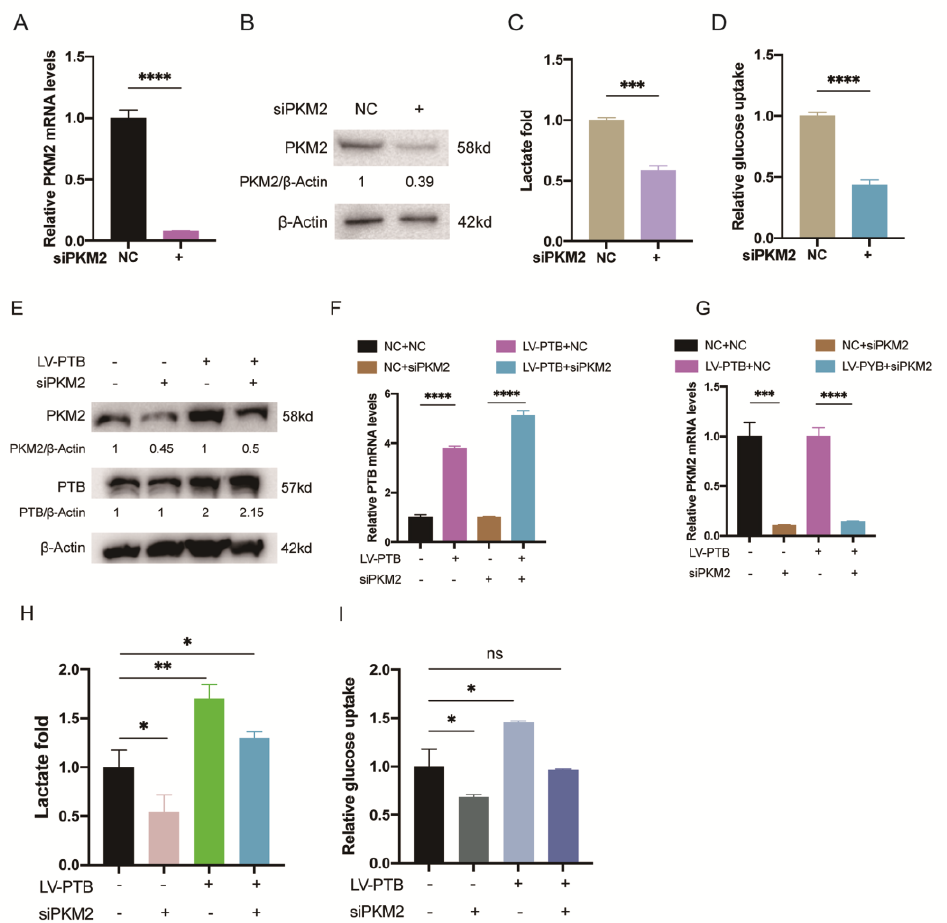
Figure 5. PTB regulates aerobic glycolysis through alternative splicing of PKM. ( A , B ) The efficiency of PKM2 silencing. Lactate production ( C ) and glucose uptake ( D ) were measured in the KFb transfected with siKM2. The overexpression efficiency of PTB and the silencing efficiency of PKM2 were confirmed by Western blotting ( E ) and qRT-PCR ( F , G ). Lactate production ( H ) and glucose uptake ( I ) were detected to measure the influence of knocking down PKM2 on the overexpression of PTB by NFb ( n = 3). Data are presented as the mean ± S.D. * p < 0.05, ** p < 0.01, *** p < 0.001, **** p <